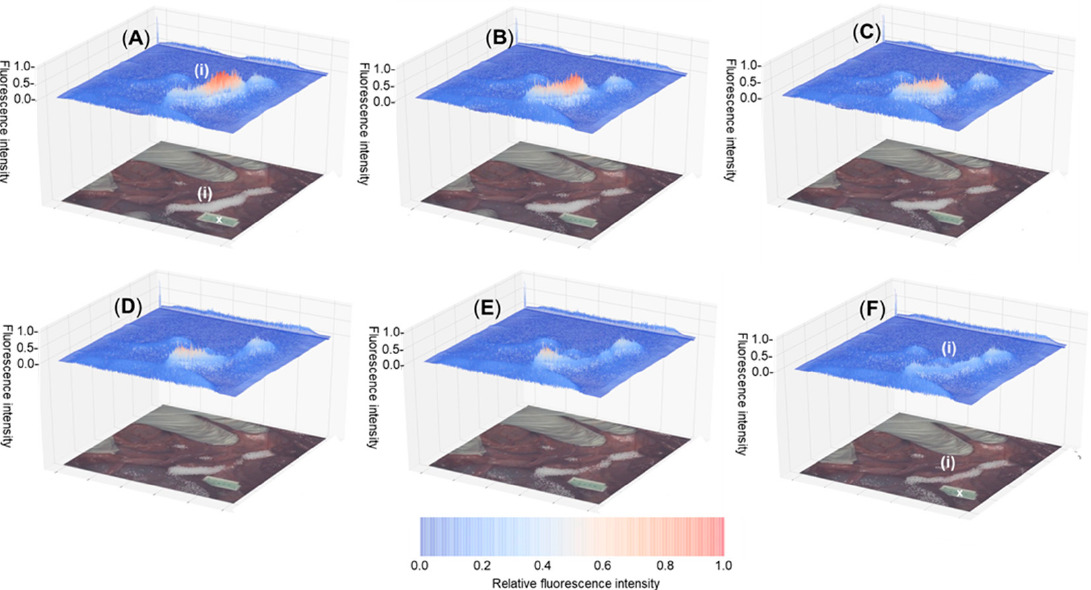
Figure 10. Fluorescence heat-map (above) showing temporal modulation of fluorescence intensity from 12 during ureteral peristalsis and tissue video image with fluorescence superimposed in white colour (below) with ureter marked as (i). Tracking a single ureteral peristaltic phase 30 min post administration with (A) to (F) recorded over 5 sec. X Indicates ICG non-emissive reference card.